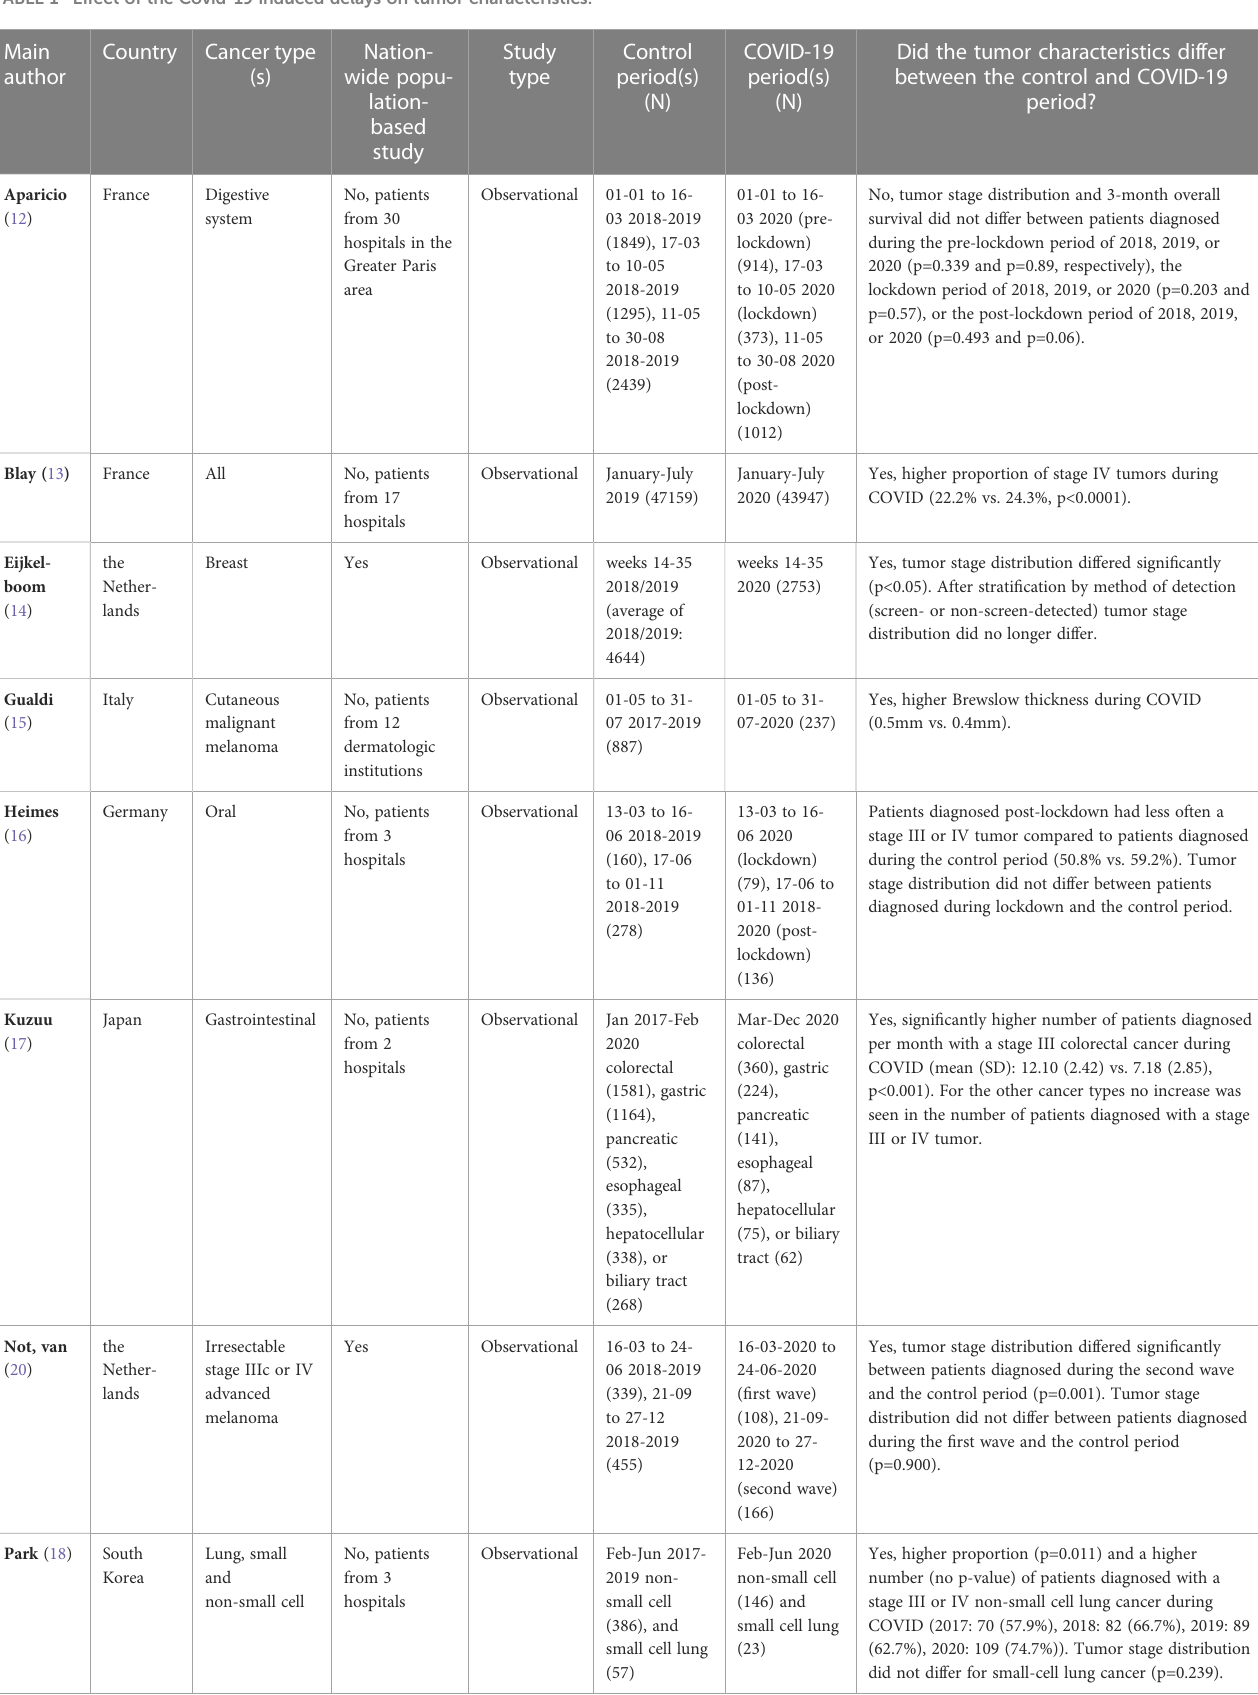
TABLE 1 Effect of the Covid-19 induced delays on tumor